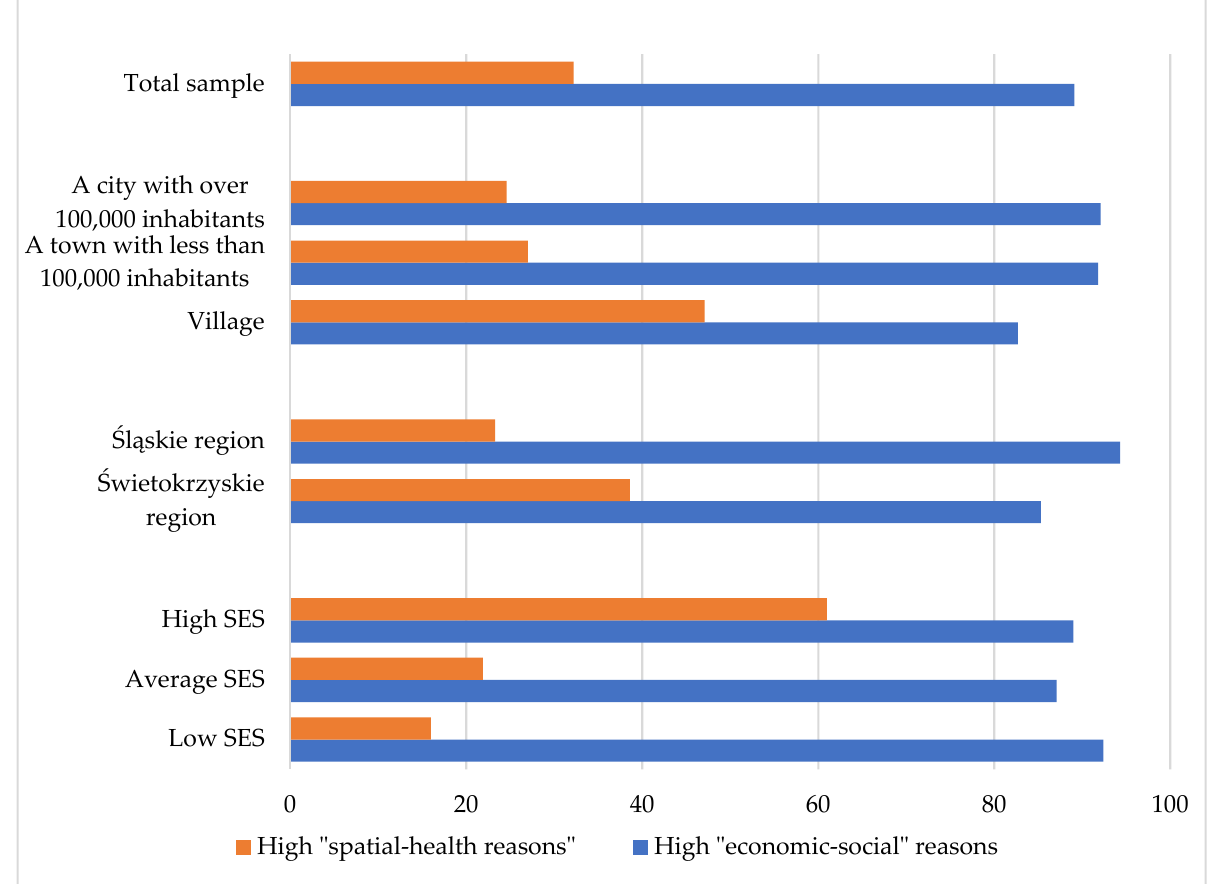
Figure 2. Importance of “economic–social” and “spatial–health” reasons for food insecurity according to selected demographic characteristics and socioeconomic status of the study sample (Chi-square test, p < 0.05).